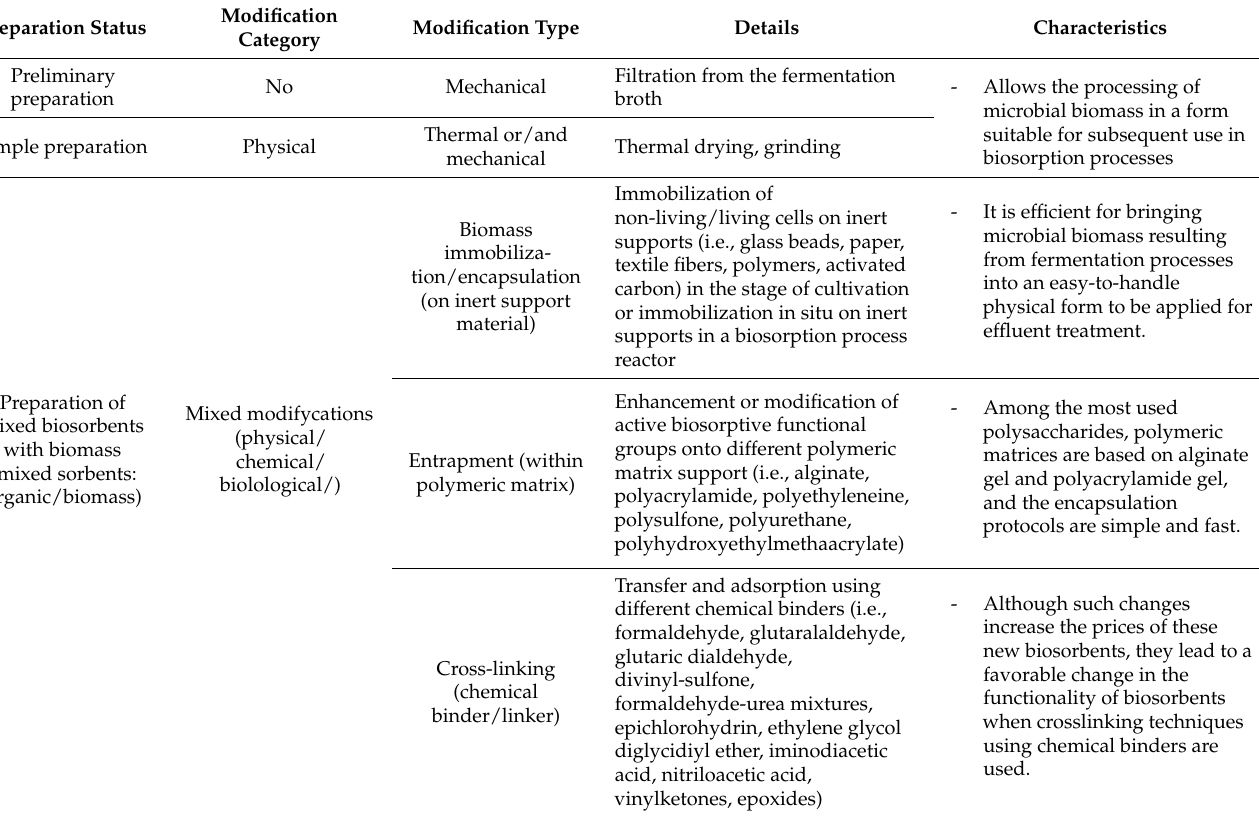
Table 5. General aspects about biosorbents preparation/synthesis (adapted from